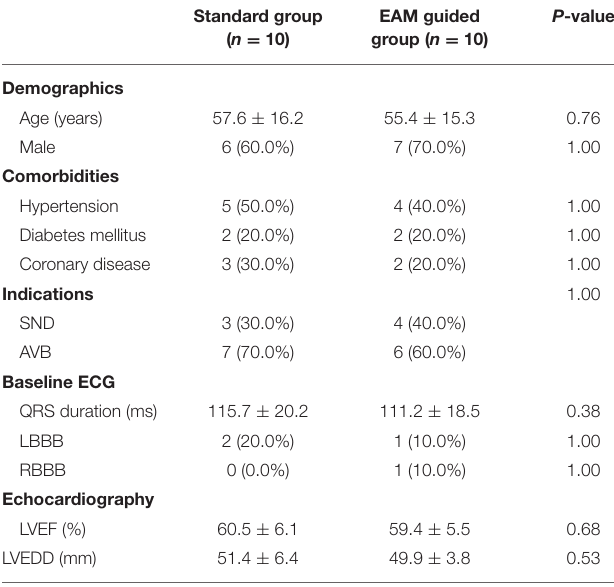
TABLE 1 | Baseline characteristics between the two